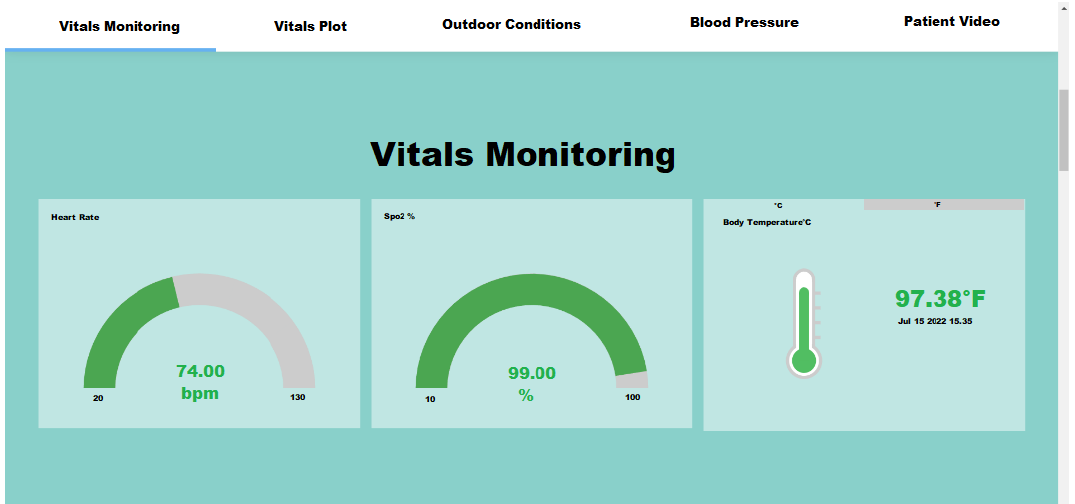
Figure 7. Vitals monitoring page in the